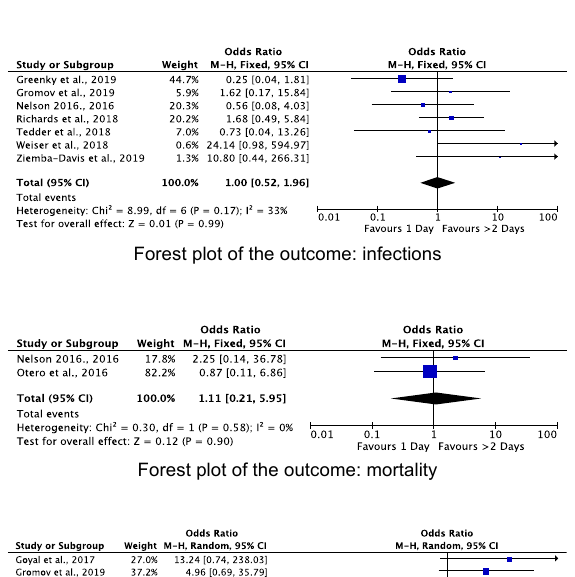
Forest plot of the outcome: deep vein thrombosis